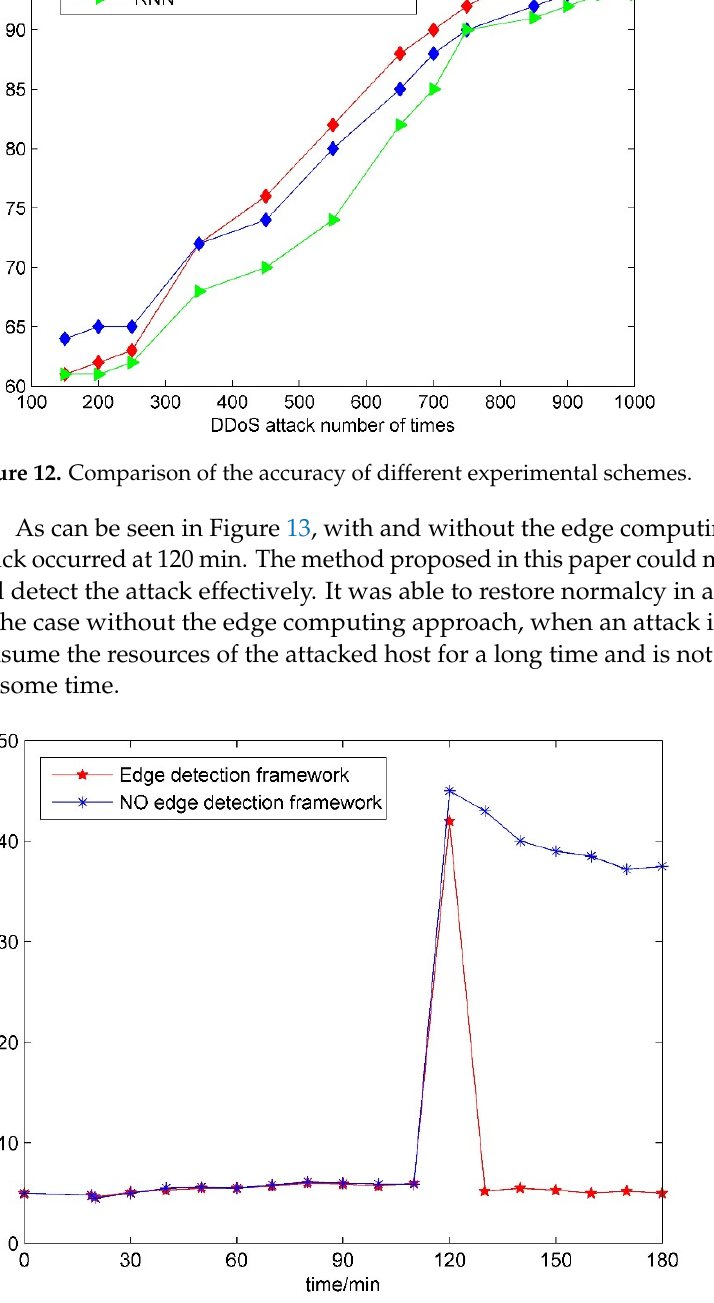
Figure 13. Time delay diagram of different detection frameworks.